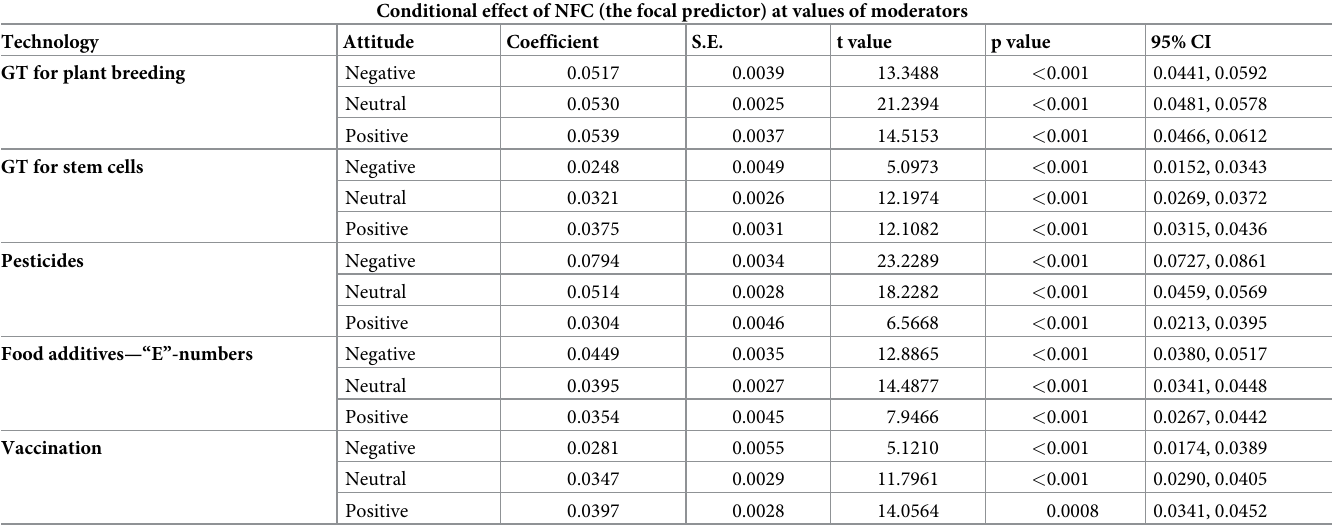
Table 6. Moderated moderation for the distance between harms and benefits for the environment. Conditional effect of the focal predictor at each value of moderators. Conditional effect of NFC (the focal predictor) at values of